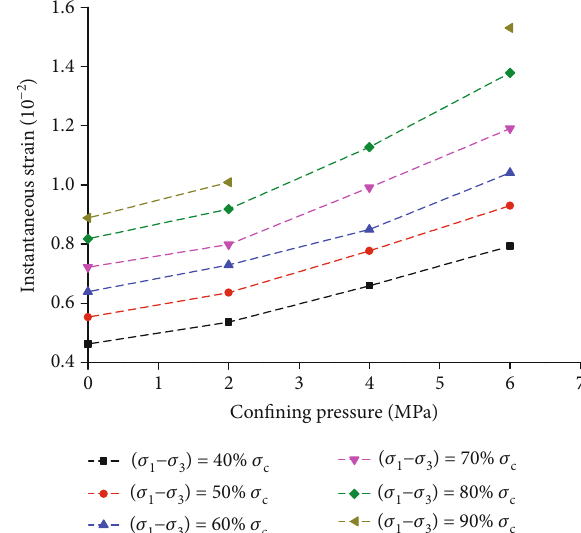
Figure 16: Curves of the instantaneous strain versus the con fi ning pressure after 9 freeze-thaw cycles for various stress levels.